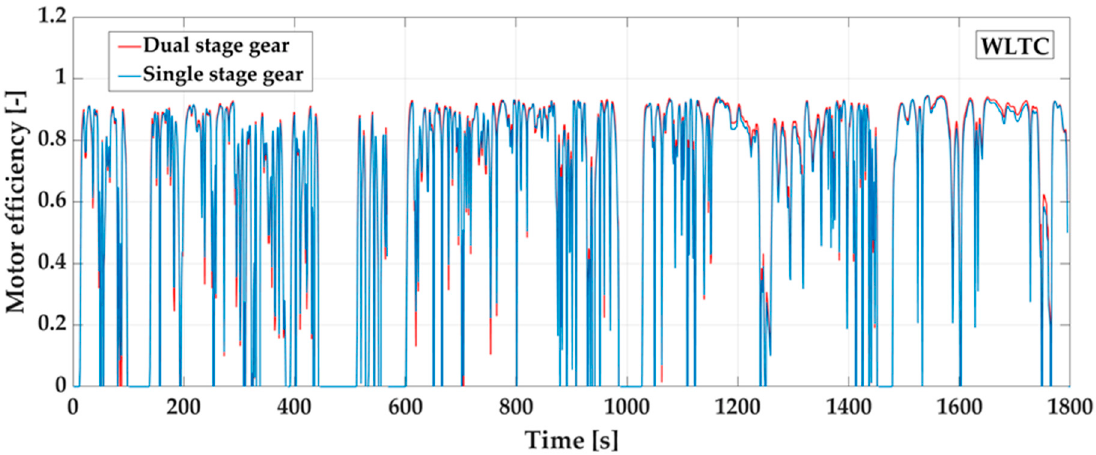
Figure 10. Motor efficiency vs. time for WLTC.